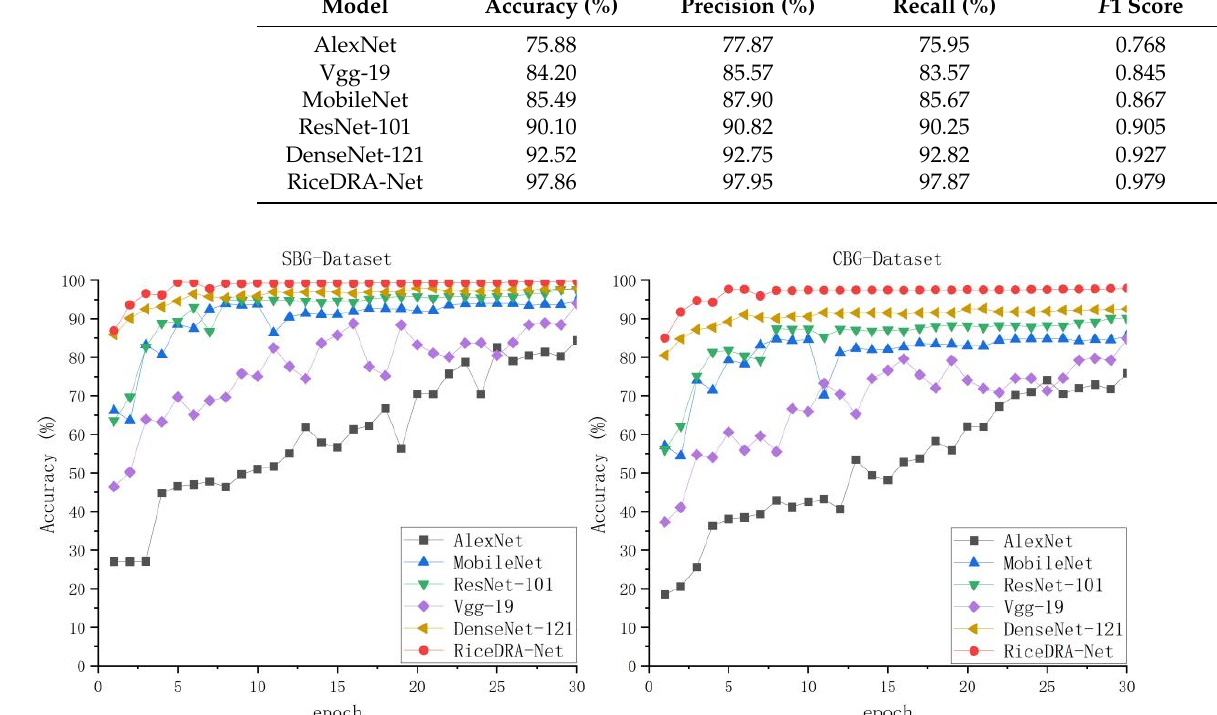
Figure 9. Comparison of various classical models in a single context.